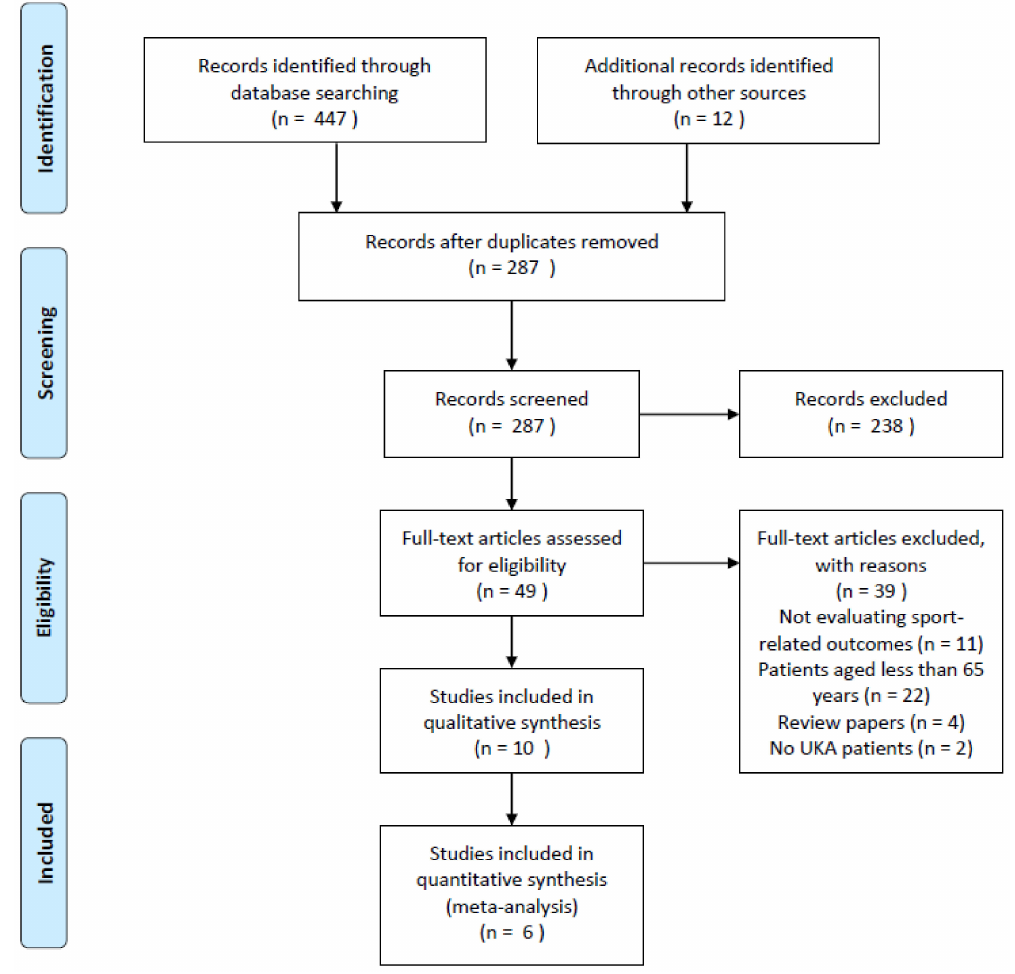
Figure 1. Study selection flowchart (UKA: Unicompartimental Knee